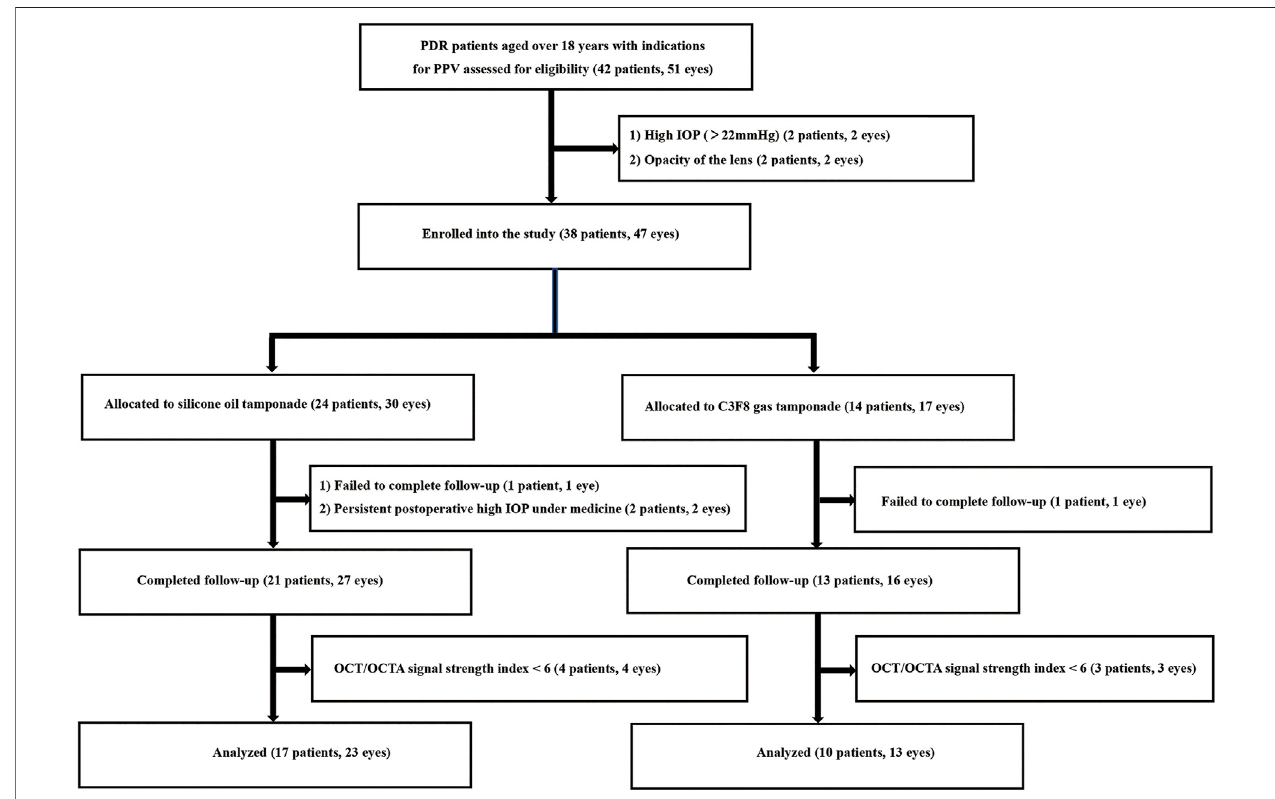
FIGURE 1 | Study fl owchart. PDR, proliferative diabetic retinopathy; PPV, pars plana vitrectomy; OCT, optical coherence tomography; OCTA, optical coherence tomography angiography; IOP, intraocular pressure; SO, silicone oil.